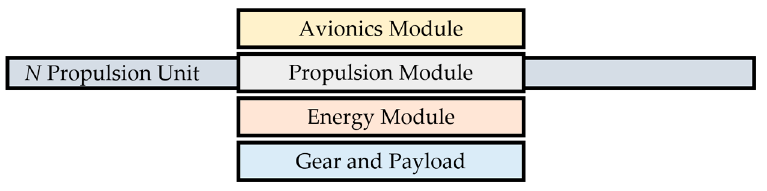
Figure 2. Modular multirotor topology.